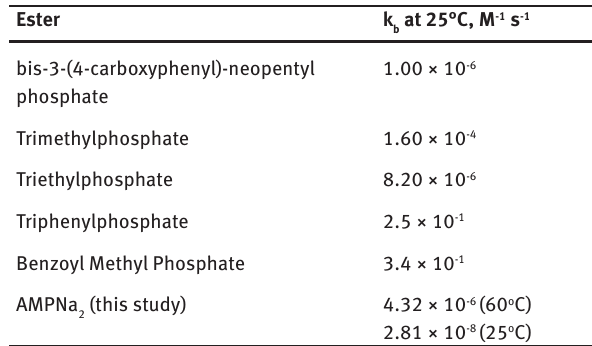
Table 1: Second-order base-catalyzed rate constant values of phosphate ester hydrolysis in previous study [10,11] and present